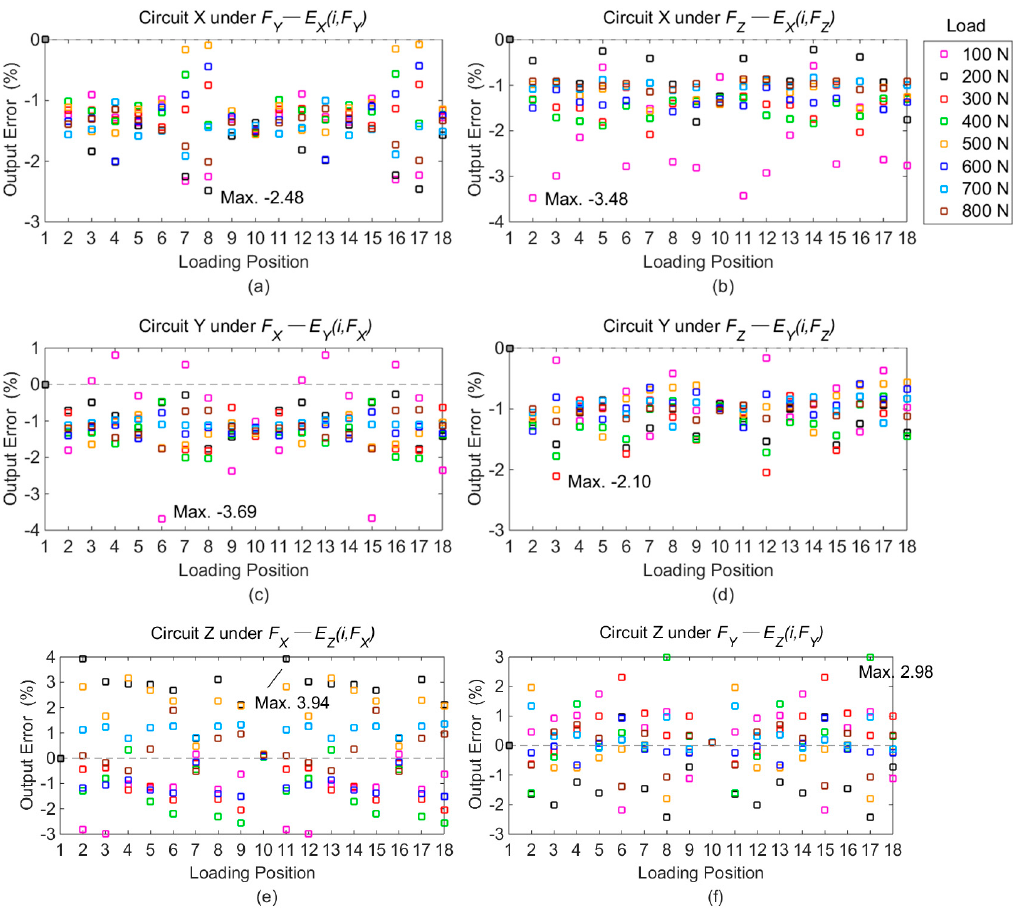
Figure 9. Differences of cross-couplings with output of Point 1 as reference: ( a ) errors in Circuit X under F Y ; ( b ) errors in Circuit X under F Z ; ( c ) errors in Circuit Y under F X ; ( d ) errors in Circuit Y under F Z ; ( e ) errors in Circuit Z under F X ; ( f ) errors in Circuit Z under F Y . Table 3. Maximal deviations of cross couplings in different